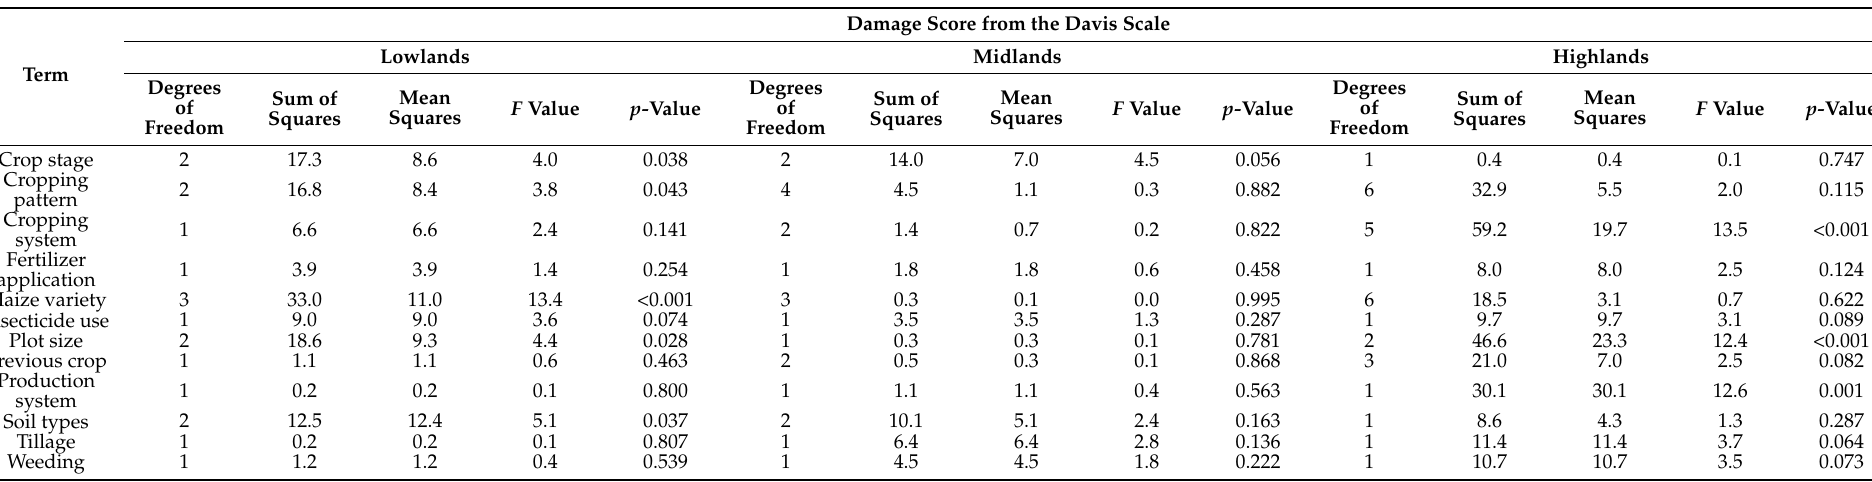
Table 6. Analysis of variance results for the disaggregated data on maize field characteristics and crop management practices employed by smallholder farmers interviewed during the survey for fall armyworm infestation and damage in three agro-ecological zones of Kenya in